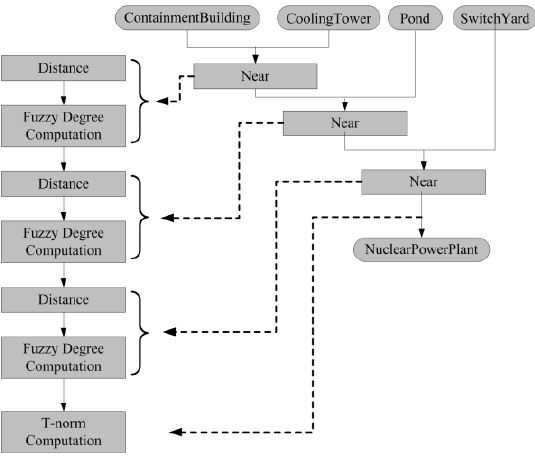
Figure 4. An uncertainty-aware service chain for